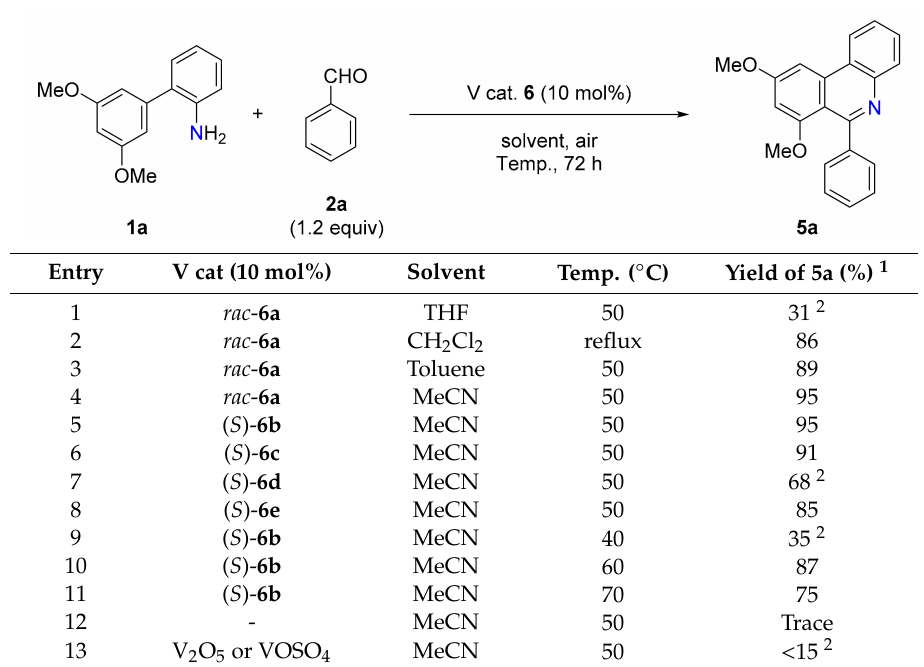
Table 1. Screening of reaction conditions.